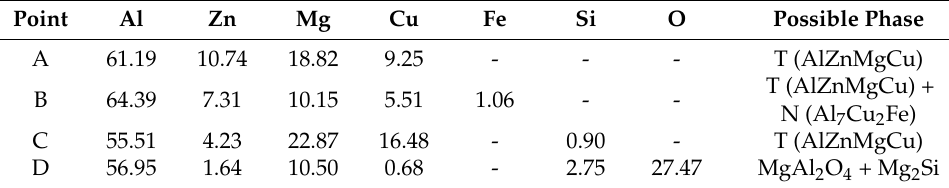
Figure 17. SEM backscattered photograph of an enlarged part of the solid–liquid bonding interface in as-cast status and its EDS surface scanning results. ( A – D are the EDS scanning points.) Table 3. EDS analysis of each point indicated by the arrow in Figure 17